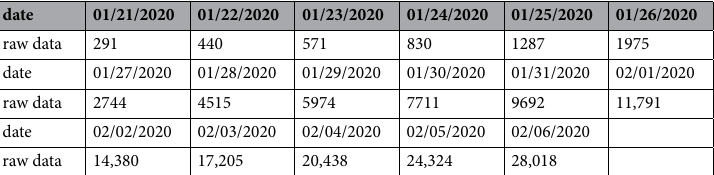
Table 8. The number of the confirmed cases from COVID-19 of